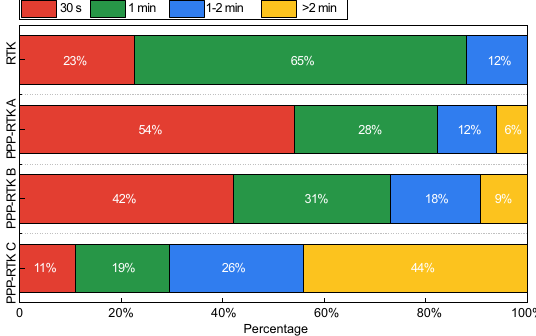
Fig. 4 Ratio of 216 samples for RTK and three PPP-RTK solutions